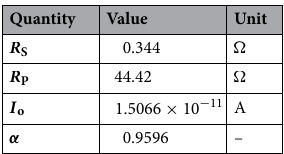
Table 2. Extracted parameters of the NST-120 PV panel by using PV array